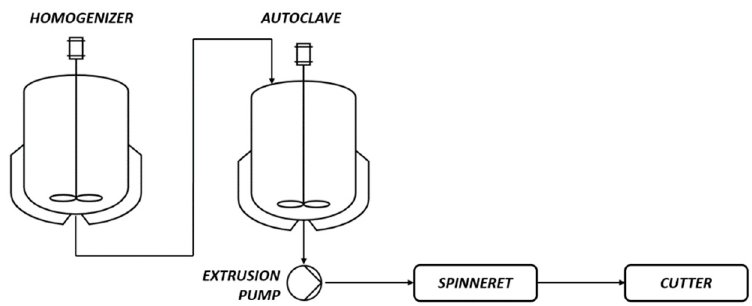
Figure 1. Basic scheme of the used polymerization